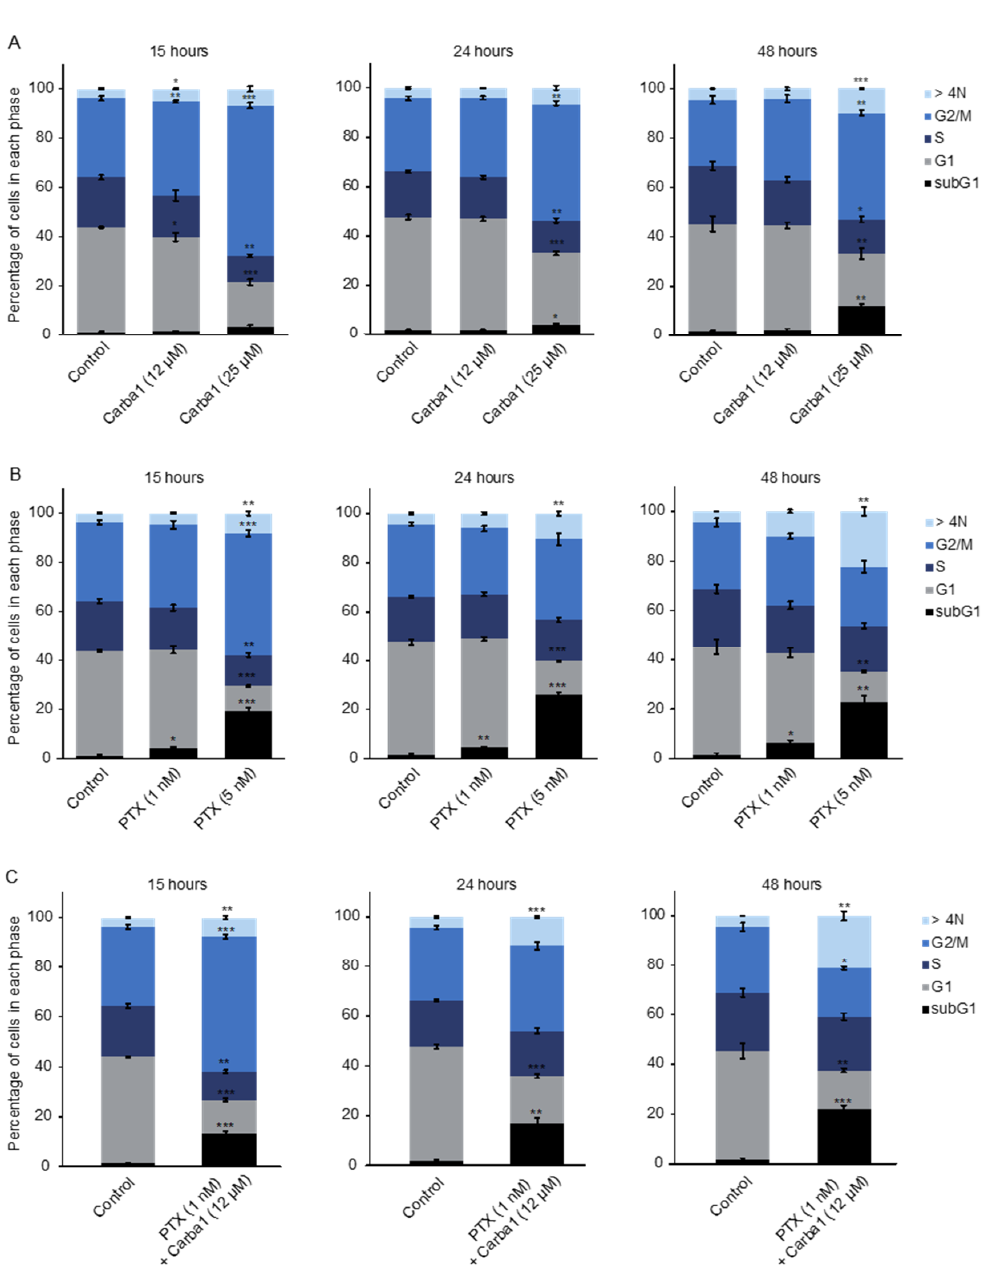
Figure 4. Carba1 increases PTX effects on cell cycle. ( A ) HeLa cells treated with the indicated concentrations of Carba1 for 15, 24, and 48 h, were fixed with 70% ethanol, stained with propidium iodide, and analyzed by flow cytometry. ( B ) HeLa cells treated with the indicated concentrations of PTX for 15, 24, and 48 h, were fixed with 70% ethanol, stained with propidium iodide, and analyzed by flow cytometry. ( C ) HeLa cells treated with the combination of Carba1 and PTX (12 µM/1 nM) for 15, 24, and 48 h, were fixed with 70% ethanol, stained with propidium iodide, and analyzed by flow cytometry. The results are expressed as mean ± SEM of three separate experiments. The significance was determined by a Student’s t -test (* p < 0.05, ** p < 0.01, *** p < 0.001, compared to the